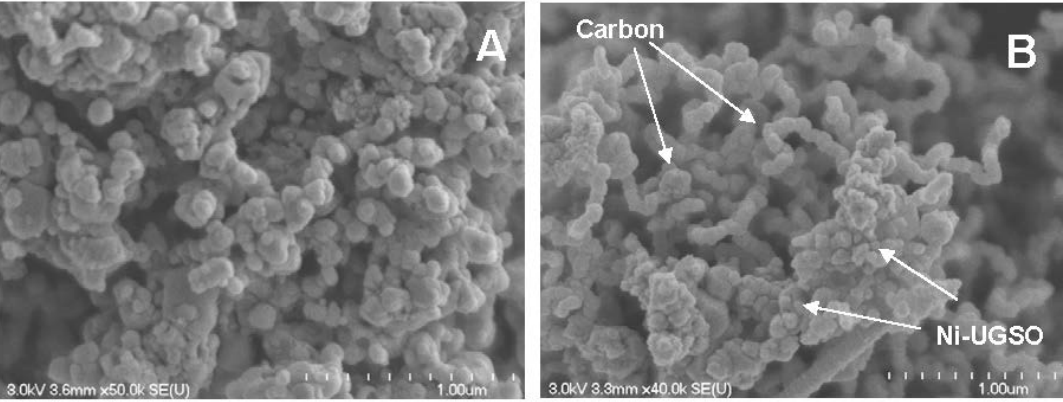
Figure 7. Micrographs of Ni-UGSO after bio-oil MemU SR at 800 ◦ C: ( A ) WHSV = 1.7 g/g cat /h; and ( B ) WHSV = 6.6 g/g cat